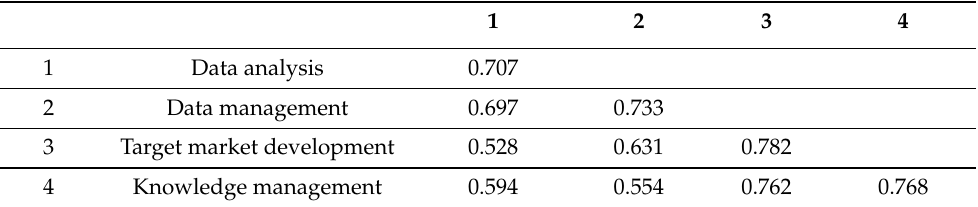
Table 2. Fornell and Larcker’s values of variables of the business intelligence questionnaire.